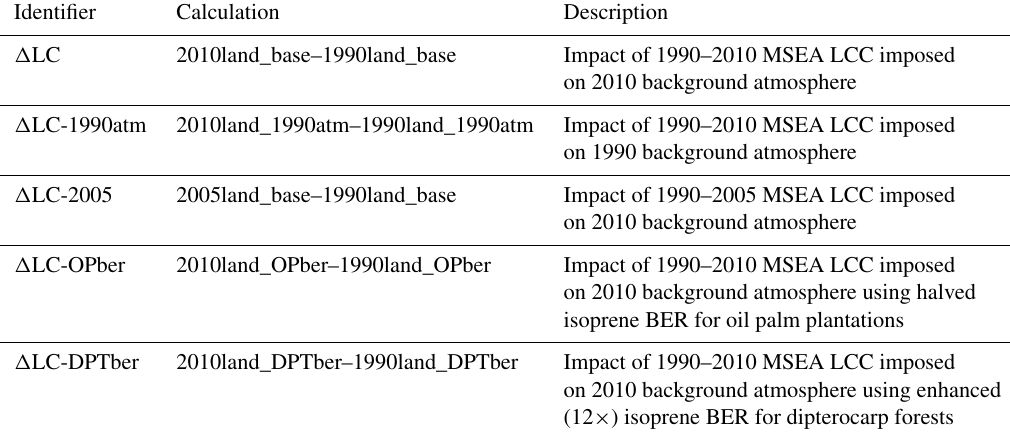
Table 4. Calculation methodology. MSEA LCC is maritime Southeast Asian land cover change. The control simulation varies between pairs of